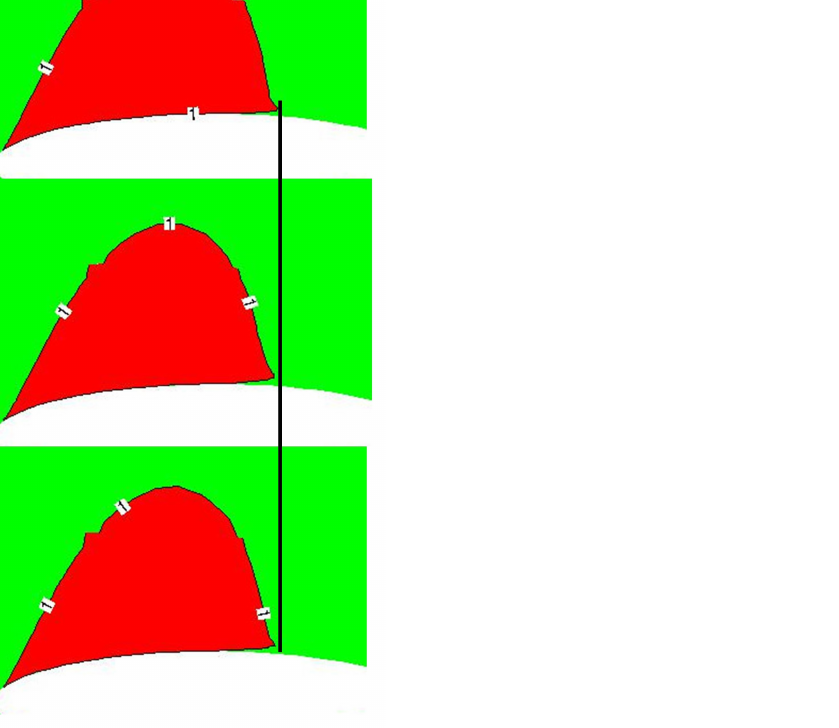
Figure 17. Wing section of NLF wing body: M ∞ = 0.64, Re ∞ = 18.2 × 10 6 , α = 4 ◦ . Visualization of the shock wave at η = 0.27 wing section (supersonic zone in red). Top: NLF without riblets, middle: turbulent without riblets (no flow control), bottom: turbulent with riblets